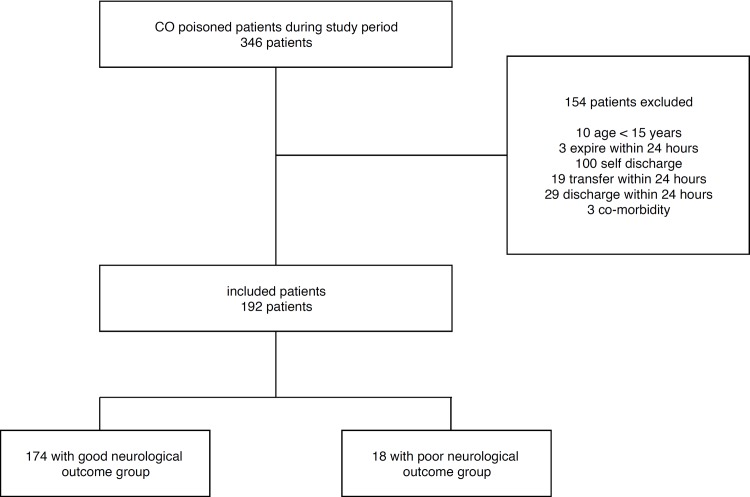
Study flow diagram of CO poisoned patients.CO: Carbon monoxide.